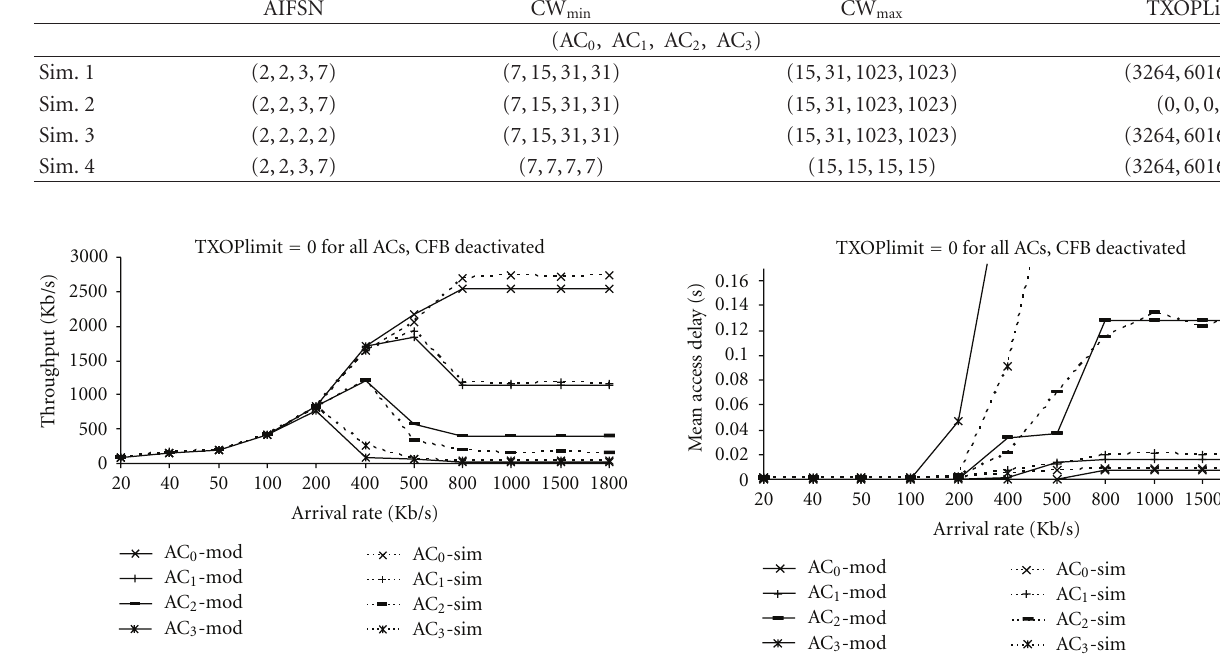
Figure 24: Achievable throughput per AC—TXOPLimit deacti- vated.